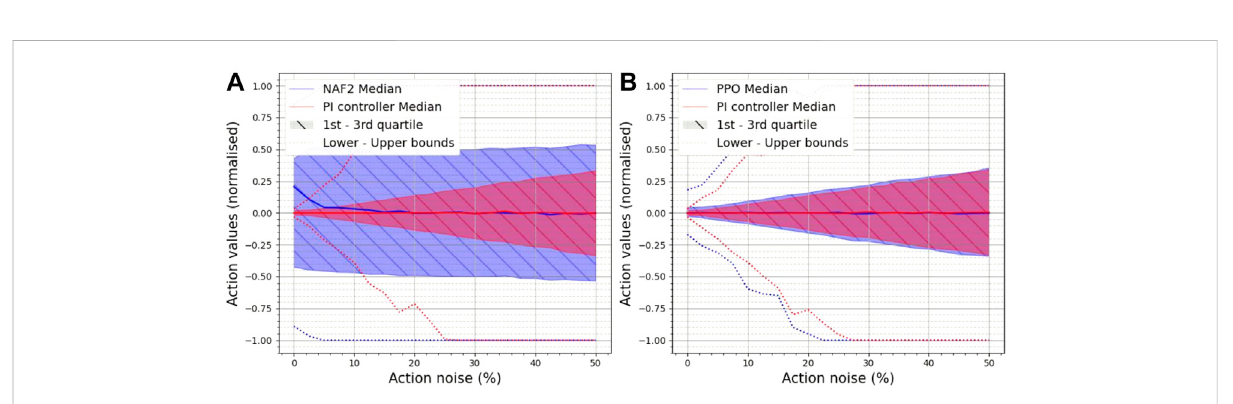
FIGURE 8 Effect of action noise on the last action used in the episode due to varying action noise on (A) the best NAF2 agent, (B) the best PPO agent and the PI